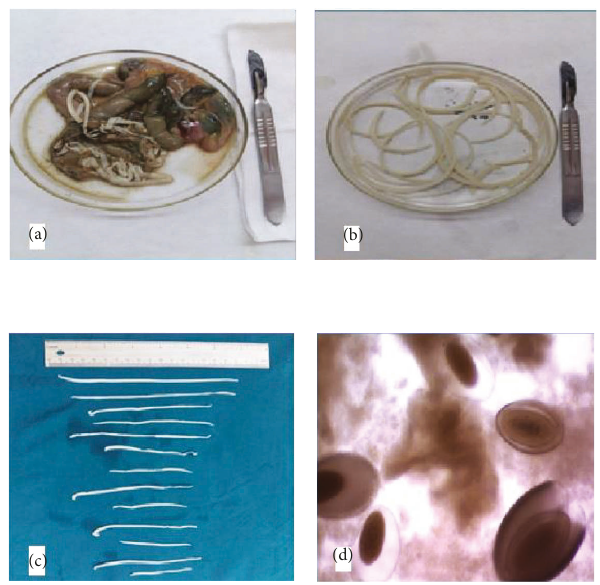
Figure 1: Macracanthorhynchus ingens specimen recovered from hedghog small intestine at post mortem. (a, b) The adult stages of M. ingens in small intestine. (C) M. ingens specimens at different life stages. (D) Eggs recovered from gravid adult female M. ingens